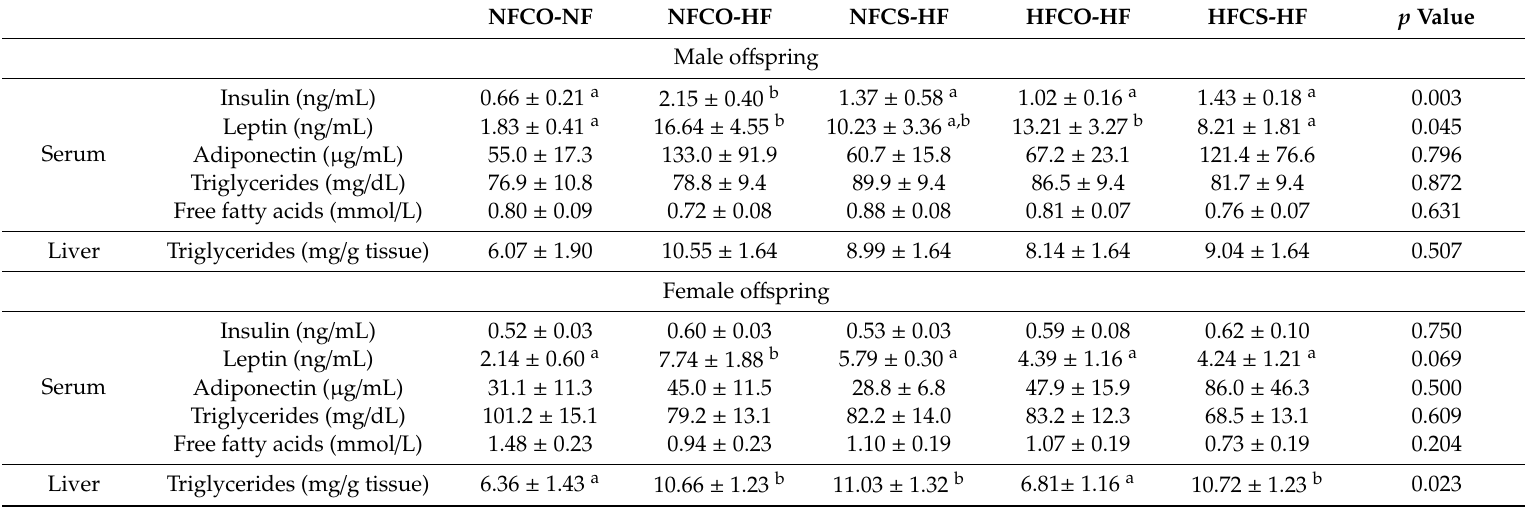
Table 1. Metabolic markers after 6-week post-weaning feeding 1